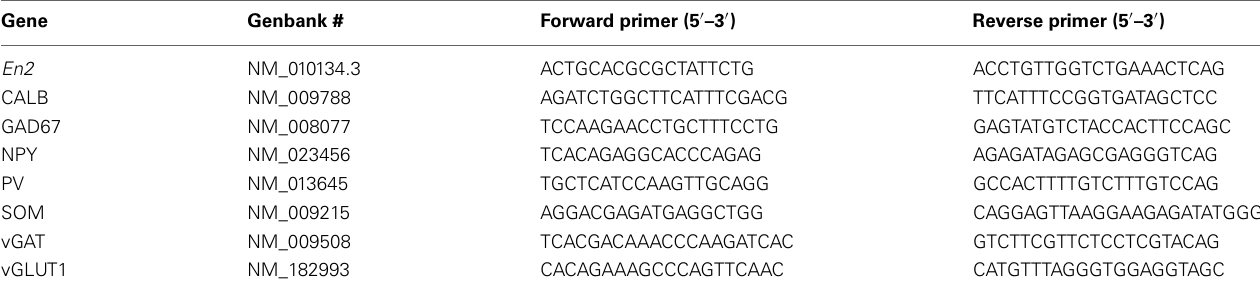
Table 1 | Primers used for quantitative RT-PCR experiments. Gene Genbank # Forward primer (5 (cid:2) –3 (cid:2) ) Reverse primer (5 (cid:2) –3 (cid:2)